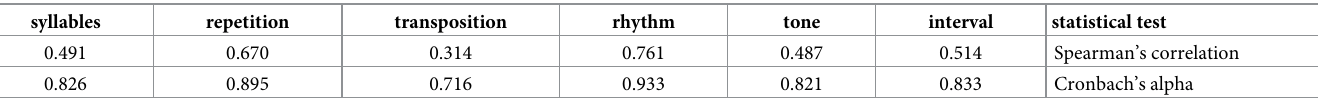
Table 1. Reliability and agreement between five raters for the six features of musical utterances.